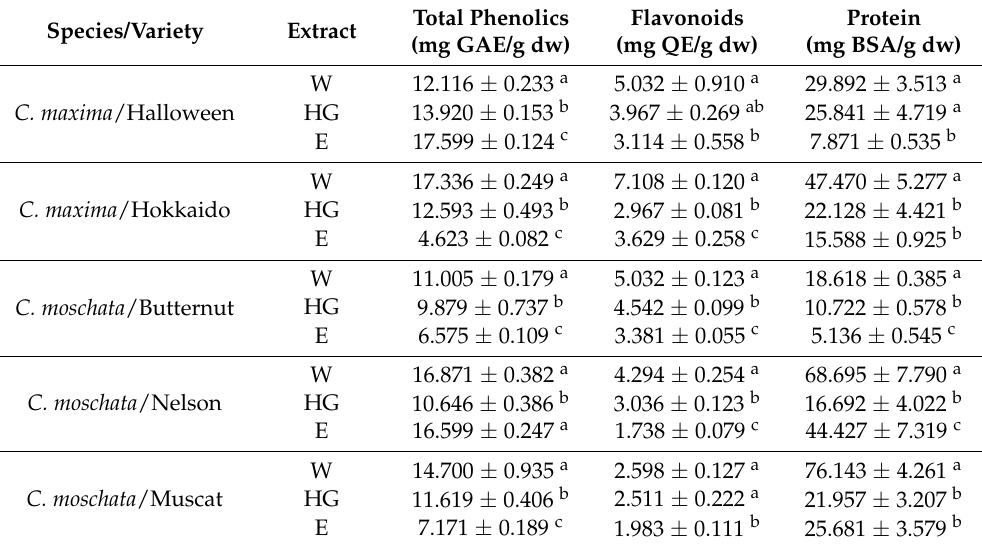
Table 1. The content of total phenolics, flavonoids, and protein in Cucurbita spp. peel extracts. Species/Variety Extract